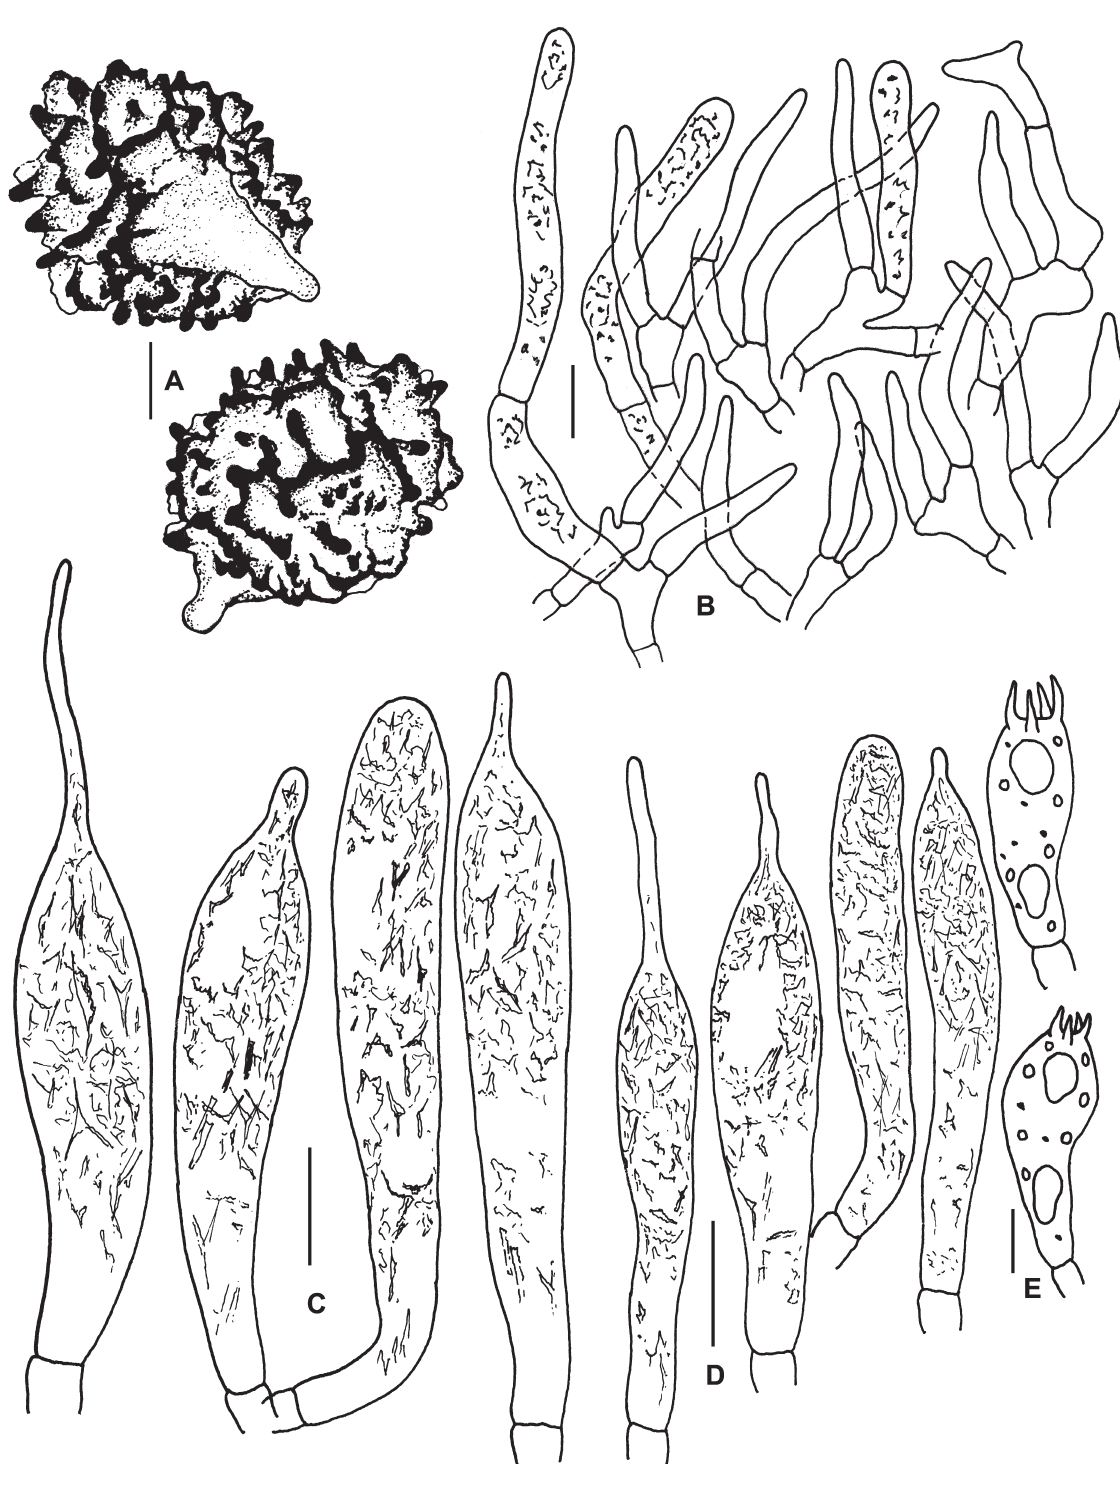
Fig. 3. Russula adwanitekae A.Ghosh, K.Das & Buyck sp. nov. (from holotype, AG 16-1430 ). A. Basidiospores. B. Elements of pileipellis: hyphal terminations and pileocystidia. C. Hymenial cystidia near the lamellae sides. D. Hymenial cystidia near the lamellae edges. E. Basidia. Scale bars: A = 2 μm; B–E = 10